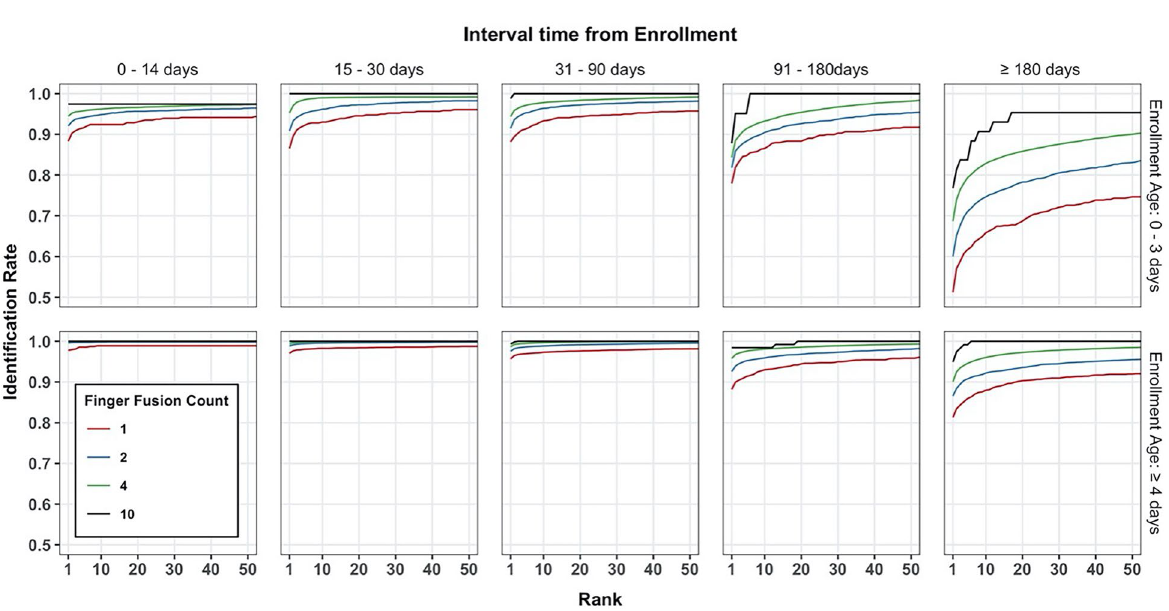
Figure 4. CMC analysis as a function of enrollment age, time gap, and the number of